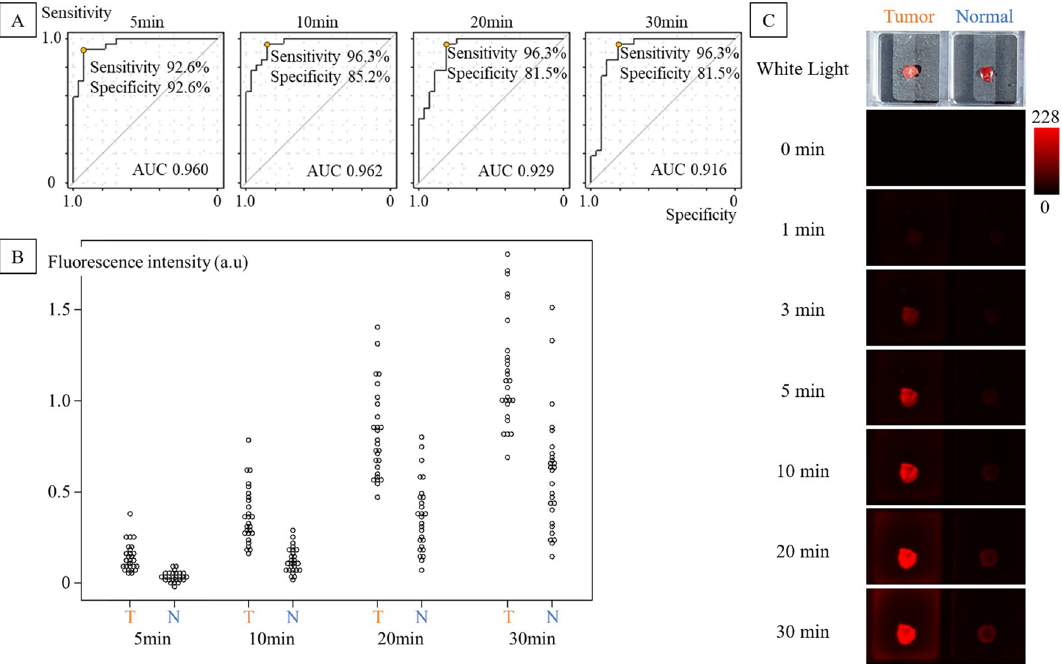
Figure 3. Imaging with QA-2MeSiR. ( A) ROC curves of QA-2MeSiR at 5, 10, 20, and 30 min in 27 fresh tissue samples. QA-2MeSiR showed high sensitivity and specificity immediately after addition, and the best result was obtained at 10 min. ( B) Dot charts of fluorescence intensity increase at 5, 10, 20, and 30 min. ( C) Pseudo-color images showing fluorescence change after addition of QA-2MeSiR. An increase of fluorescence in the tumor can be recognized immediately after probe